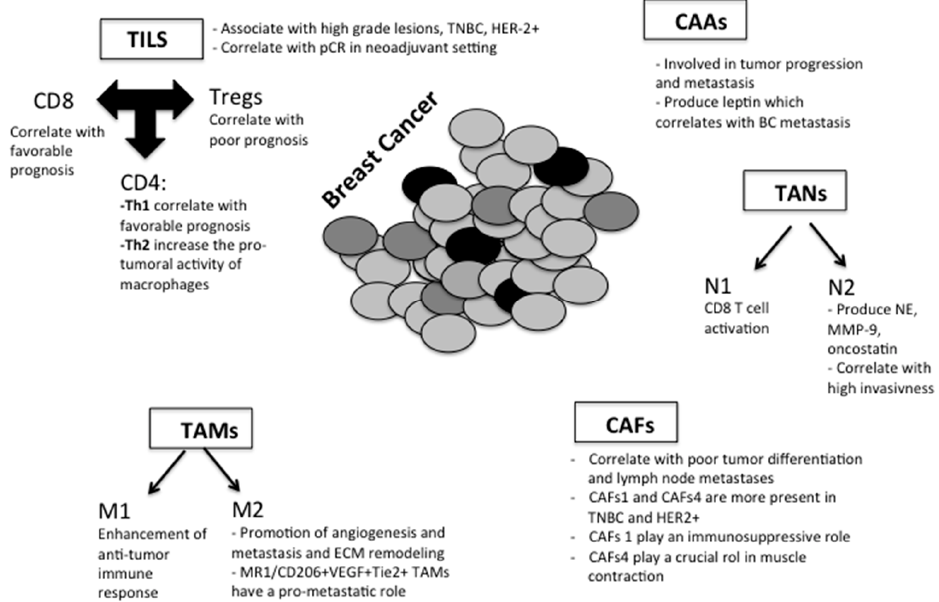
Figure 3. Schematic drawing of the role of cellular and non-cellular components in breast stroma during tumor initiation and progression. Within the tumor microenvironment (TME) there is an array of resident cells, non-resident cells, and secretory elements contributing to the progression and metastasis of breast cancer cells. Tumor-infiltrating lymphocytes (TILs) strongly correlate with good prognosis, in particular in triple-negative and HER2-positive breast cancer patients. T-lymphocytes (CD3+) are the main component of TILs and include CD4+, CD8+ and T-regulatory cells (Treg). Effectively, TILs CD8+ and Th1 cytokines correlate with favorable prognosis, whereas it has been reported a strong association between an increase in Treg-infiltrating and –circulating cells and subsequent breast cancer metastases. Tumor-associated macrophages (TAMs) can express a broad spectrum of activation states. They can have a “classical” tumoricidal phenotype (M1) and an “alternatively” activated tumor-promoting phenotype (M2). It is recognized that perivascular macrophages, involved in the tumor microenvironment of metastasis (TMEM), are a subpopulation of TAMs (Tie2+/VEGF+) with strong pro-angiogenic activity. Similar to macrophages in TME, neutrophils can polarize in two distinct subtypes and N2 tumor-associated neutrophils (TANs) inactivate T-lymphocytes and promote cancer growth. Cancer-associated fibroblasts (CAFs) are the main cell component of breast cancer stroma and are able to secrete a wide range of proteases, inflammatory molecules and growth factors, overall inducing tumor progression and worsening clinical outcome. Cancer-associated adipocytes (CAAs) differ from the normal adipocytes in metabolic activity and leptin production and have been shown to be deeply involved in tumor progression and